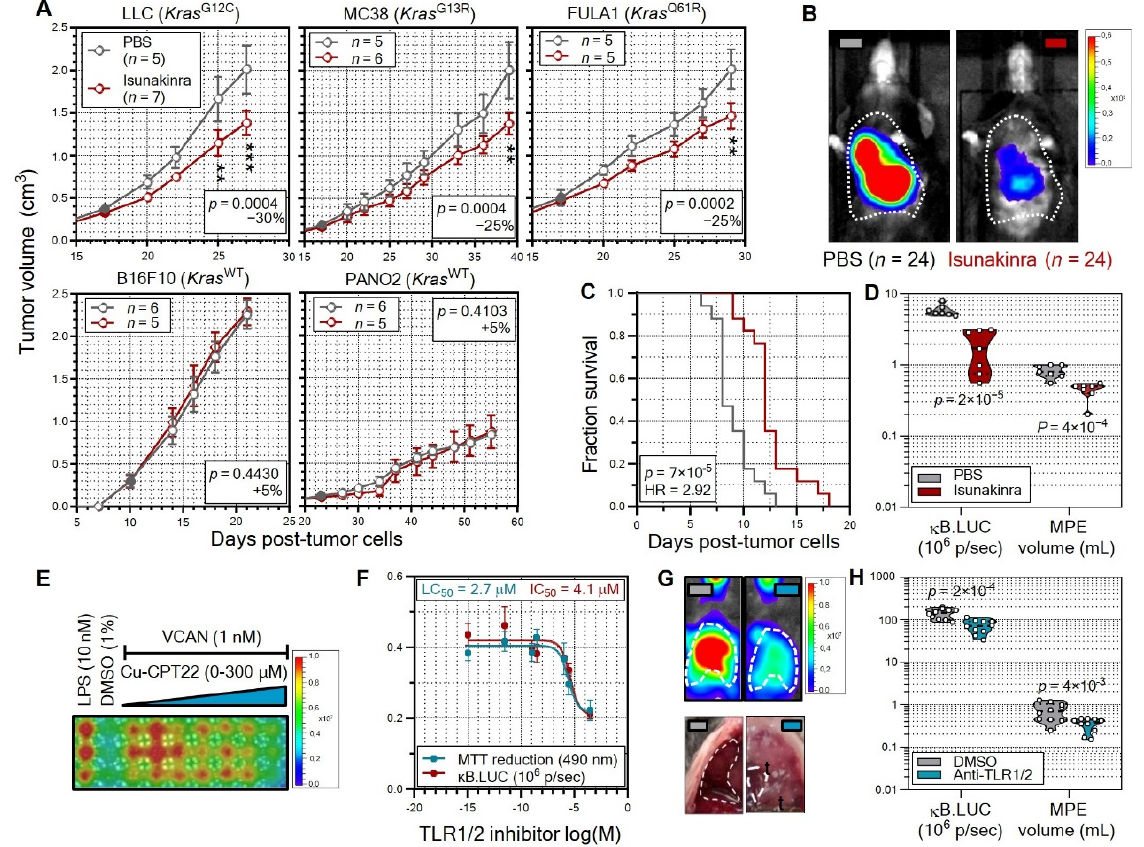
Figure 6. Pharmacologic abolition of non-oncogene addiction of Kras -mutant tumors to IL-1 β . ( A – D ) The IL-1 receptor antagonist isunakinra limits nuclear factor (NF)- κ B activation and tumor growth of Kras -mutant cancer cells. ( A ) FVB ( n = 10) and C57BL/6 ( n = 45) mice received subcutane- ous injections of 5 × 10 6 FULA1 ( FVB mice) or LLC, MC38, B16F10, or PANO2 ( C57BL/6 mice) cells that carry G12C, G13R, Q61R, or wild-type ( WT ) Kras alleles. Mice were allowed 10–23 days for tumor take (solid circles) and were treated with daily intraperitoneal PBS or 20 mg/Kg isunakinra until control tumor volume reached 1 cm 3 (PANO2 cells) or 2 cm 3 (all other cell lines). Shown are mouse numbers ( n ), tumor volume as mean (circles) and SD (bars), two-way ANOVA probability ( P ) for treatment effects, and average isunakinra effect at the last time-points (%). ** and ***: p < 0.01 and p < 0.001, respectively, Bonferroni post-tests. ( B – D ) C57BL/6 mice received intraperitoneal PBS or 20 mg/Kg isunakinra ( n = 7/group) followed 1 hr later by 10 6 intrapleural LLC cells stably expressing a κΒ .LUC reporter ( NGL ), and were imaged for bioluminescence 4 hrs later. Shown in ( B ) are repre- sentative chest (dotted lines) bioluminescent images with pseudo color scale. In addition, FVB mice ( n = 48) received 2 × 10 5 intrapleural FULA1 cells, were allowed 5 days for tumor take and received daily intraperitoneal PBS or 20 mg/Kg isunakinra. Mice were sacrificed when morbid for survival analyses ( n = 17/treatment) or at day 14 post-tumor cells for malignant pleural effusion (MPE) anal- yses ( n = 7/treatment). Shown in ( C ) are Kaplan–Meier survival estimates (curves) with log-rank